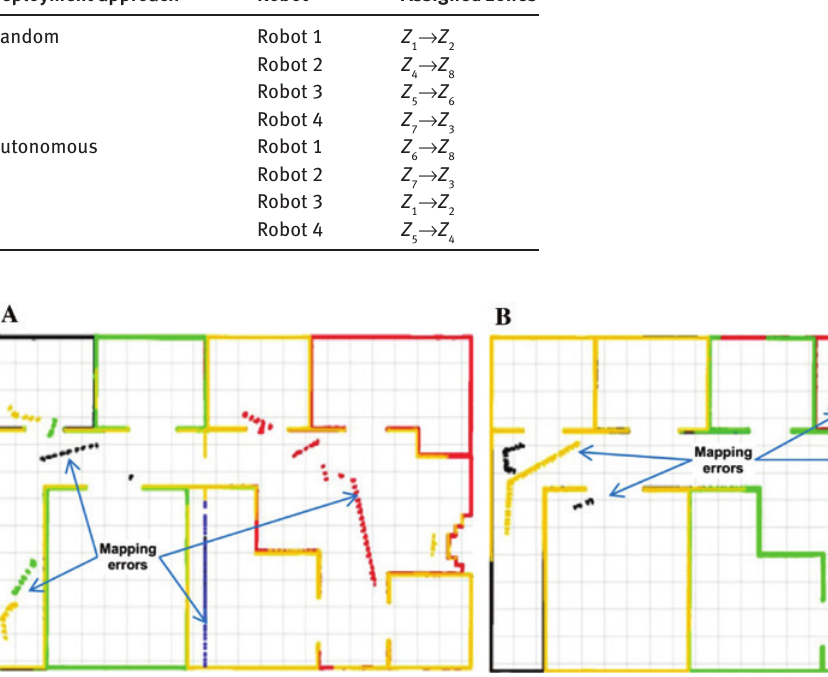
Table 5: Assigned Areas for the Scenario with Four Robots. Deployment approach